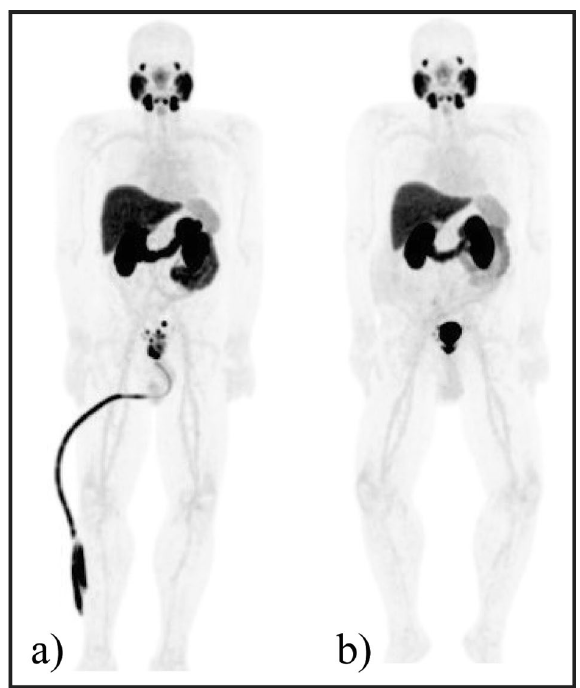
Fig. 3 a Patient 01 MIP pre-surgery PSMA PET/CT; b Patient 01 MIP post-surgery